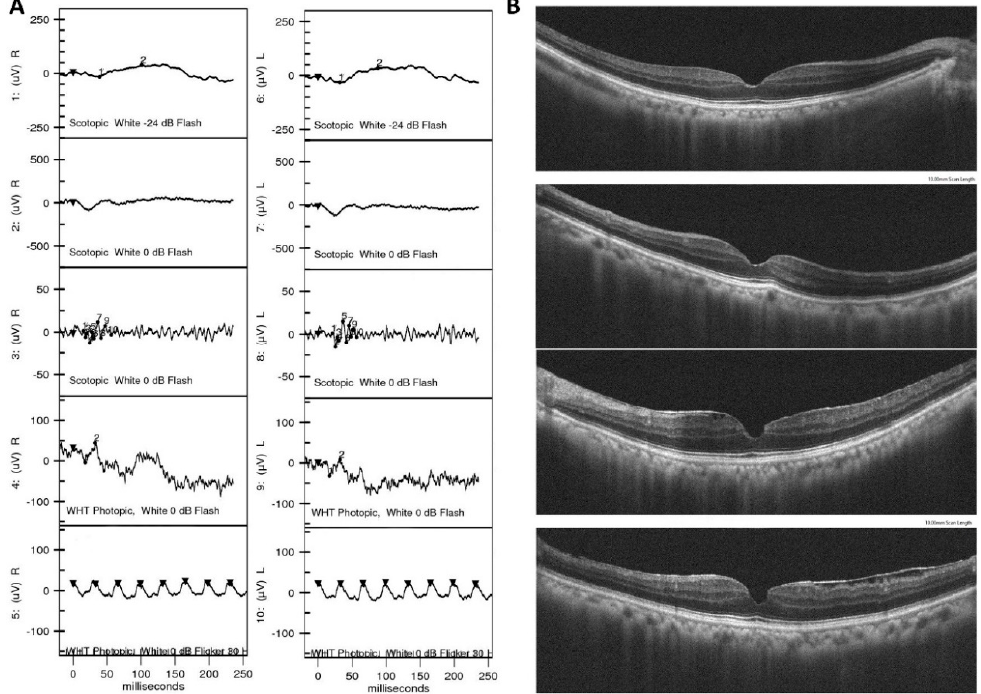
Figure 6. OCT and ffERG of a 72-year-old male patient who was molecularly diagnosed with CADASIL. Typical pathological findings in the central nervous system including ischemic stroke, intracerebral hemorrhage, and vascular dementia were noted, and we further found decreased amplitude in almost every mode of ffERG ( A ), which demonstrated degenerative changes in retinal neurons. OCT exam revealed relatively well-preserved architecture, except for a minor epiretinal membrane in the left eye ( B ).